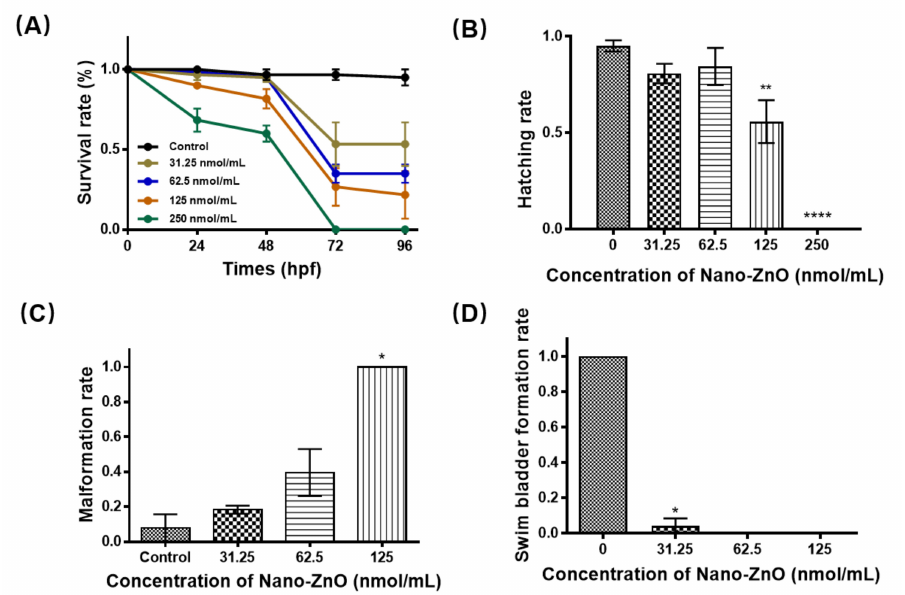
Figure 3. The effect of nano zinc oxide on ( A ) the survival rate, ( B ) the hatching rate, ( C ) the malformation rate, and ( D ) the swim bladder formation rate. Data are expressed as means ± SD. ( n = 30, * p < 0.05, ** p < 0.01, **** p <